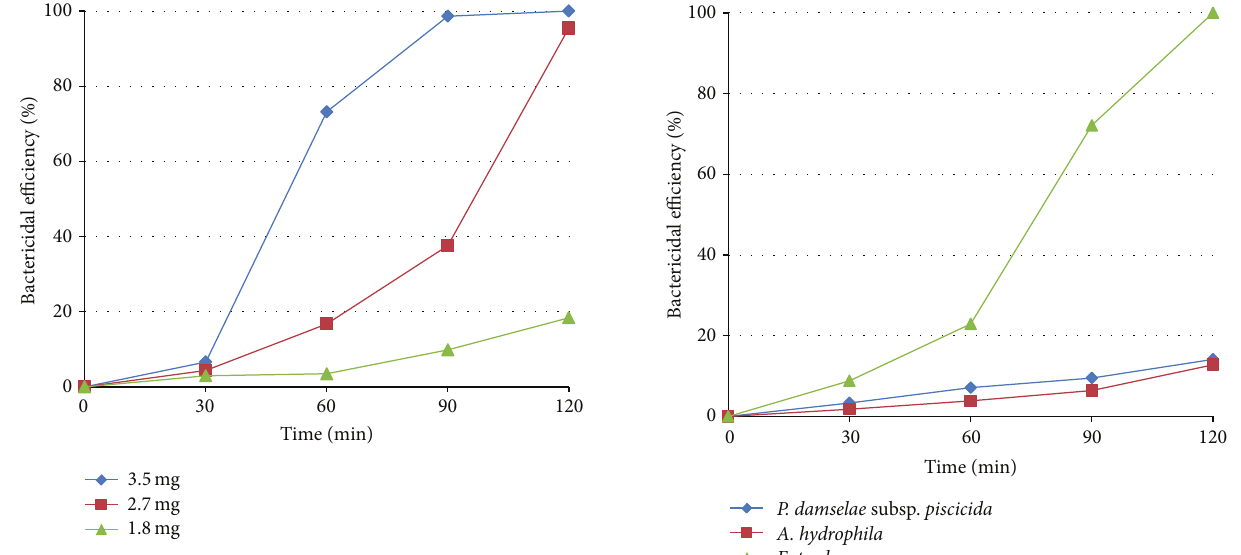
Figure 11: Photocatalytic bactericidal efficiency for Aeromonas hydrophila (BCRC13018) at different loadings of Ag-TiO 2 /Fe 3 O 4 under visible light irradiation.